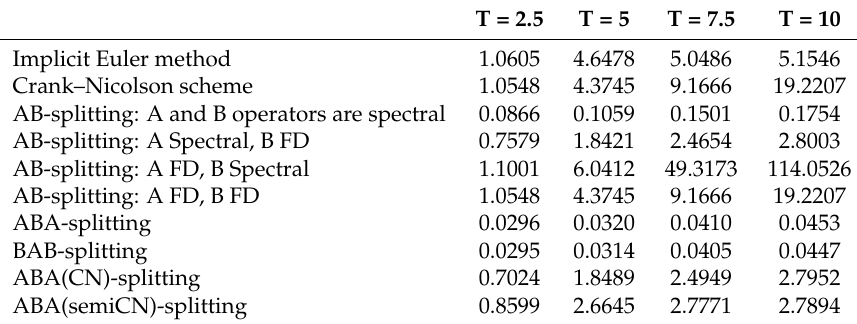
Table 6. Numerical errors of two solitons with the different